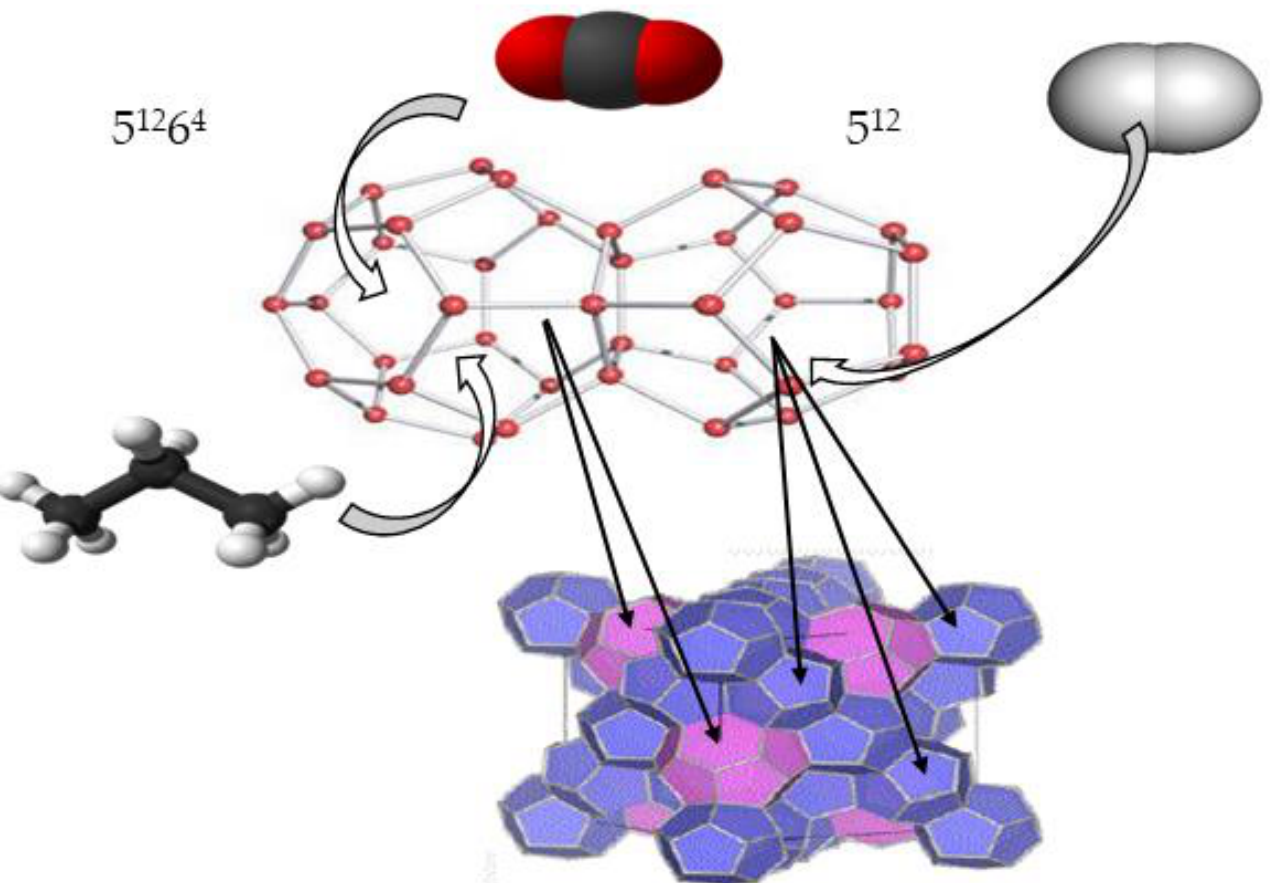
Figure 3. According to the theory, the molecules of hydrogen would occupy the small cages (5 12 ), while the other gases will fill the large cages (5 12 6 4 in the sII), thus ensuring the stability of the hydrate lattice and favoring its formation at reasonable pressures and temperatures.